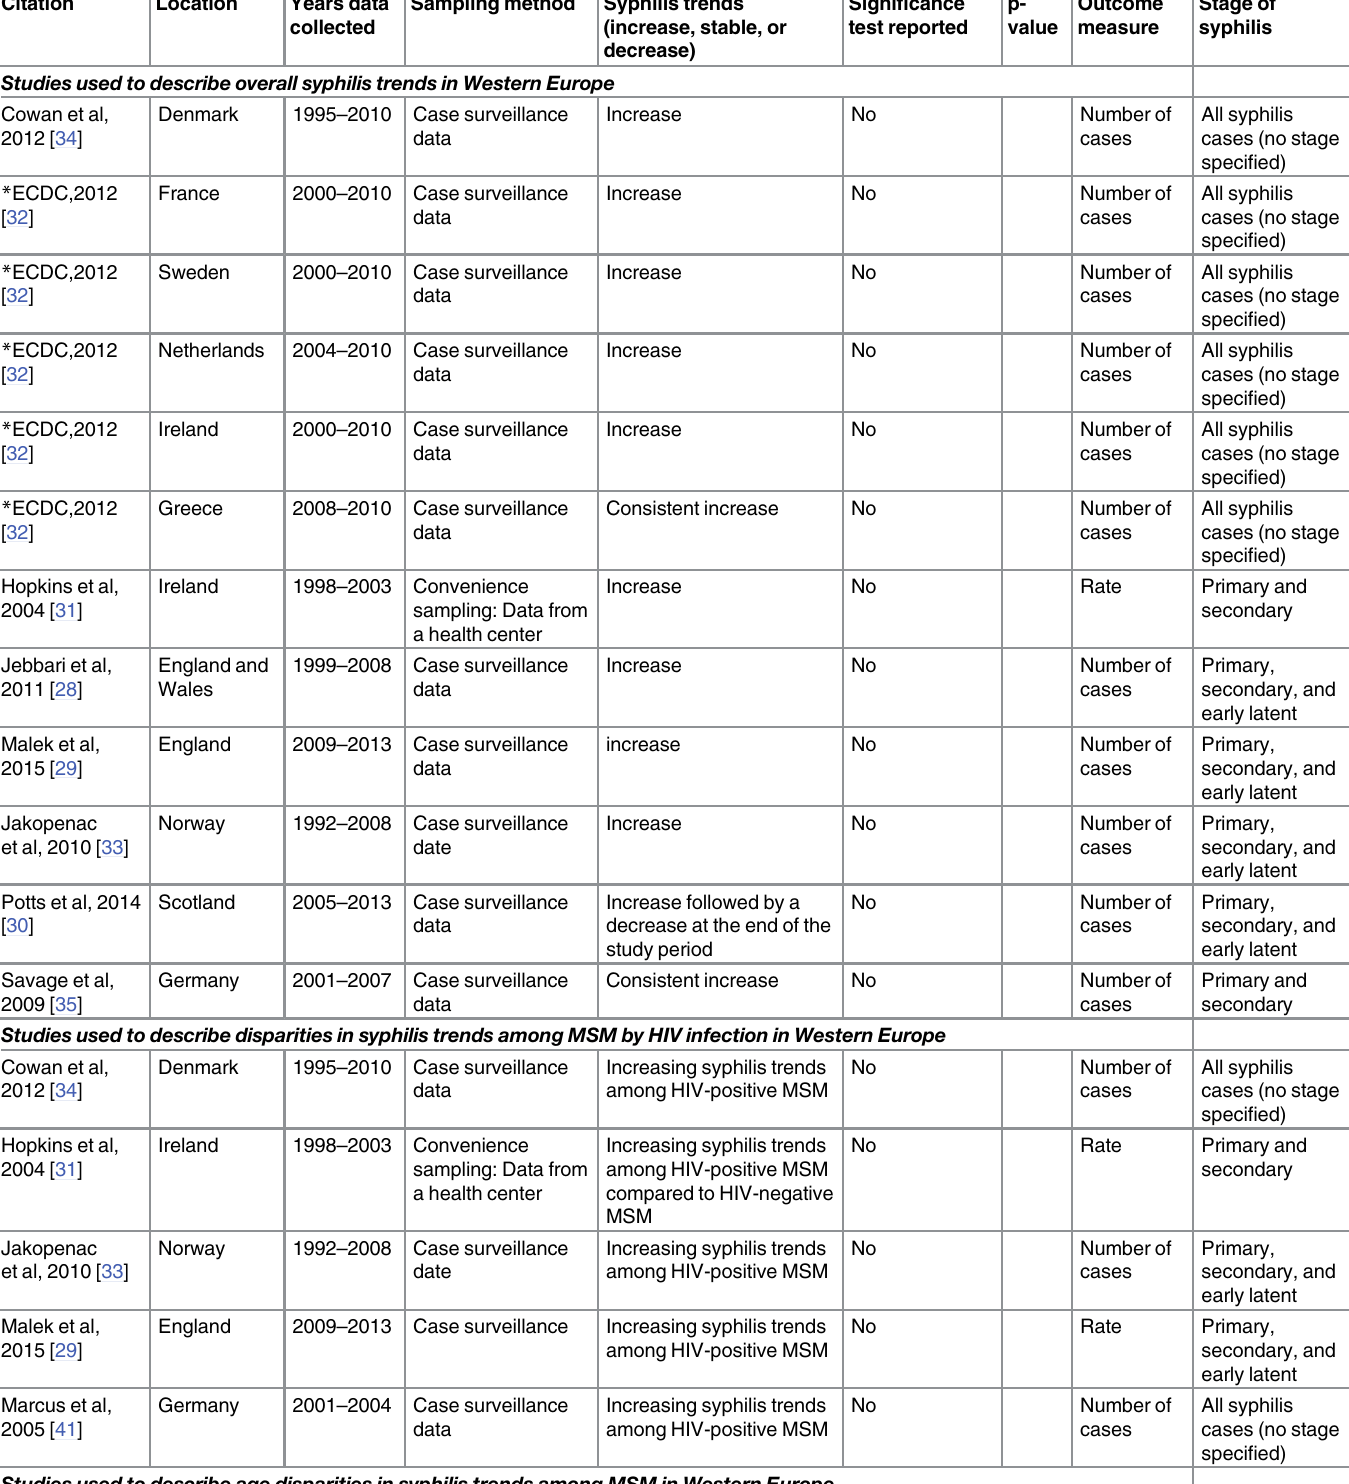
Table 2. Syphilis trend studies among MSM conducted in Western Europe, 2004 –